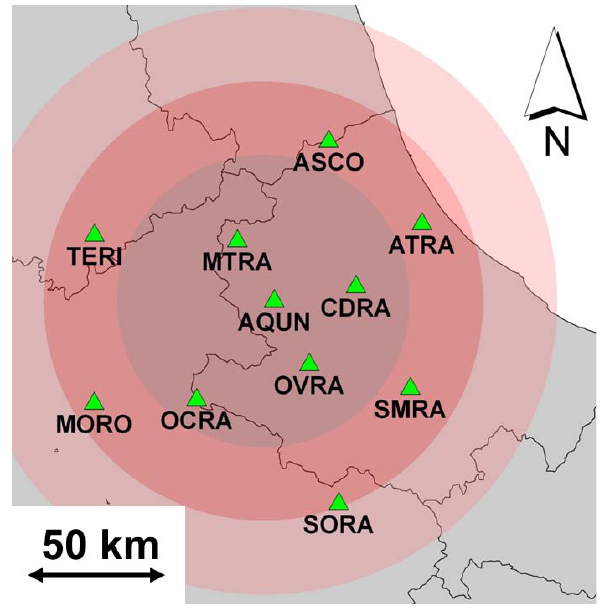
Fig. 5. Map of the GPS CORSs in the middle of Italy.